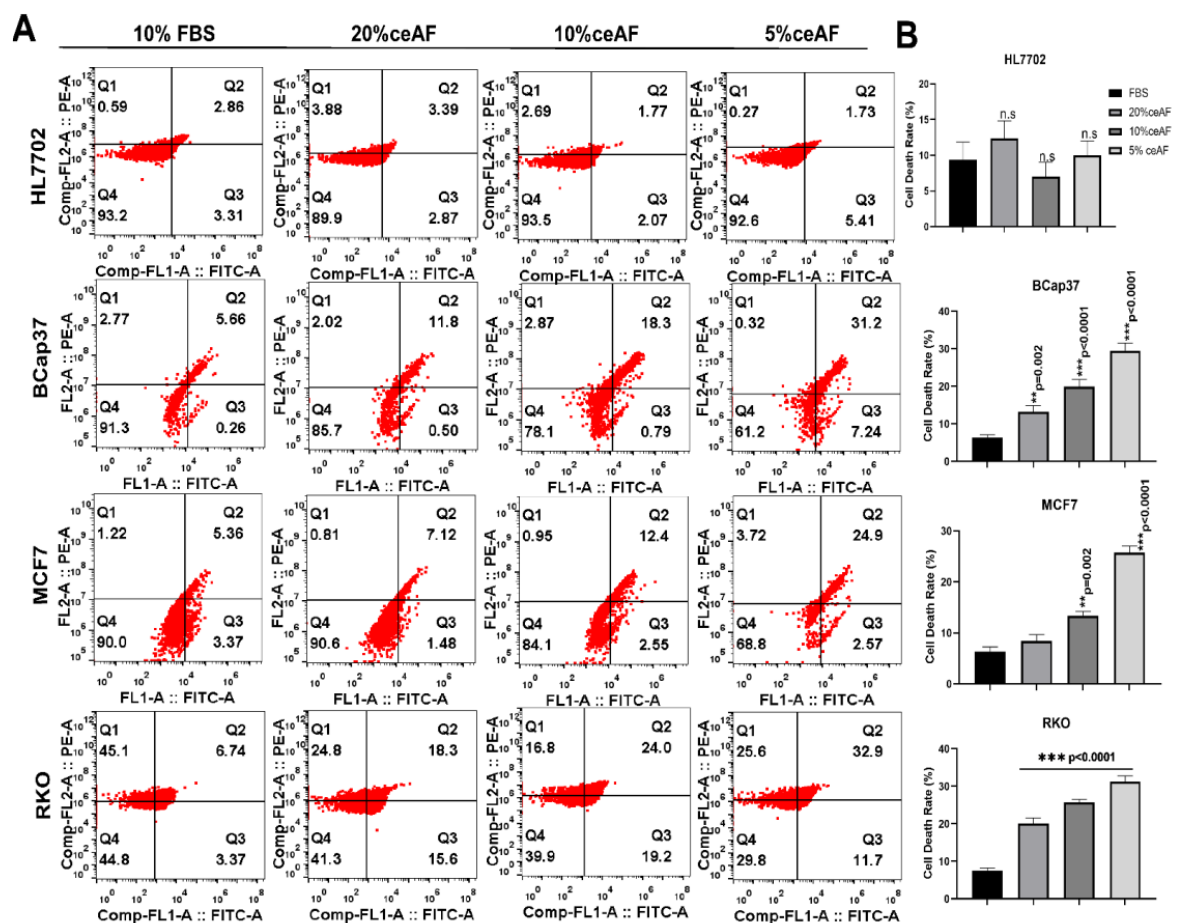
Figure 3. ceAF induces apoptosis of tumor cells via MAPK-ERK signaling as determined by annexin V-FITC signaling. ( A ) Tumor cells were treated with ceAF and, after synchronization, subjected to annexin v staining. Flow cytometry determined the percentage of apoptotic cells; relative quantifi- cation is shown in the right panel ( B ). Significance was measured using a one-way ANOVA where Dunnett’s multiple comparisons test was used to compare control (10% FBS) with other groups., ** p < 0.01, and *** p < 0.001.